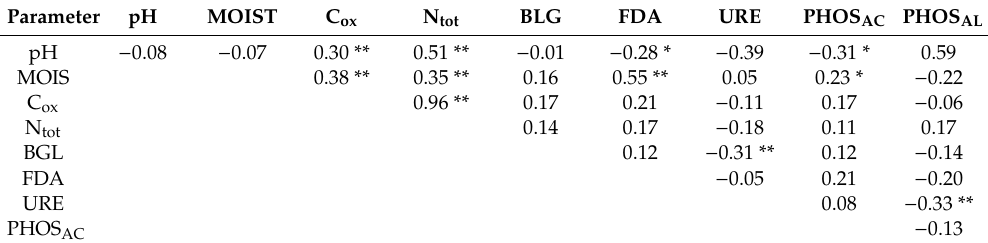
Table 4. Correlation relationship between analysed soil characteristics (regardless the year of study, ecosystem and invasion